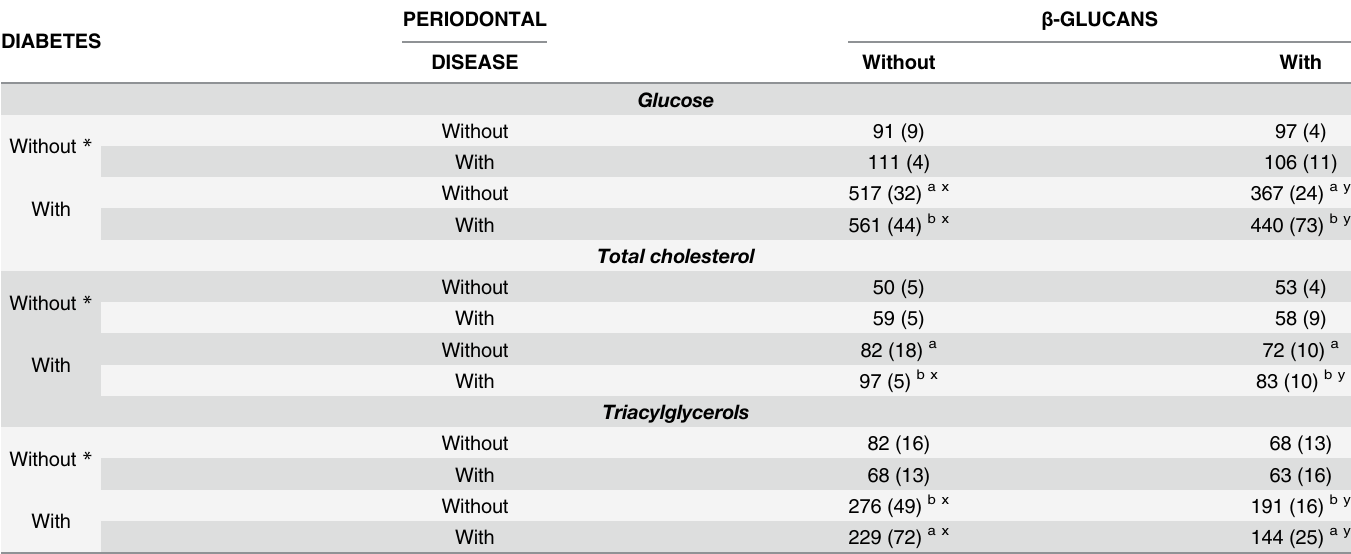
Triacylglycerols Without With Without With 144 (25) a y